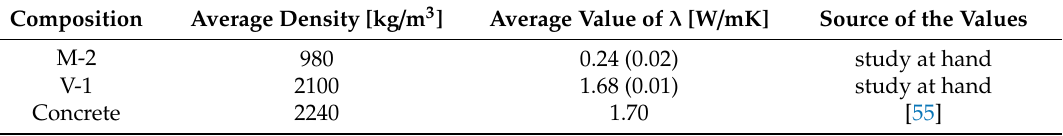
Table 9. Results of the thermal conductivity measurements; standard deviation is given in parenthesis. Composition